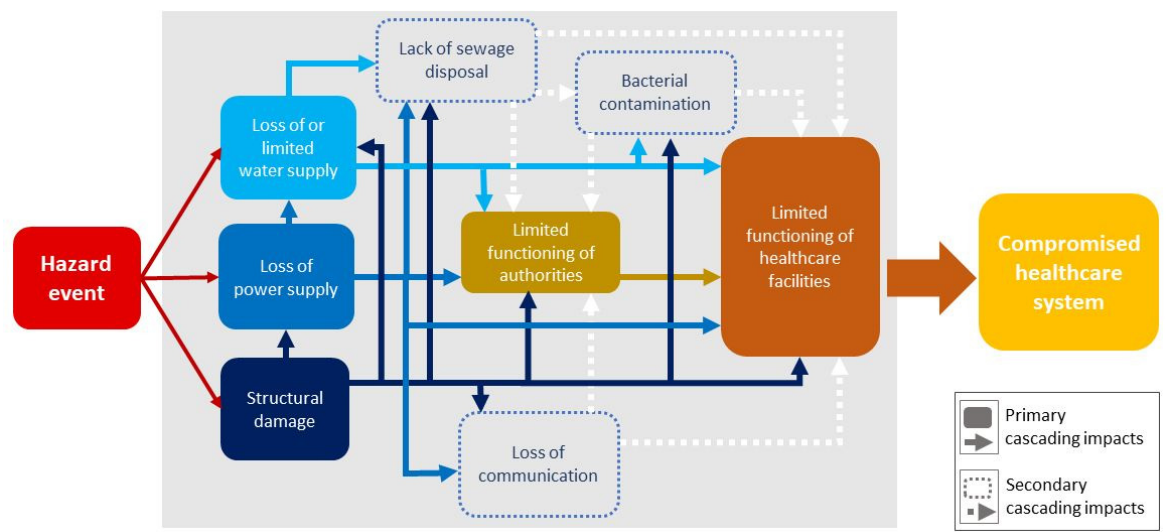
Figure 2. Visualization of cascading impacts triggered by hazard events leading to a compromised healthcare system based on the selected case studies.